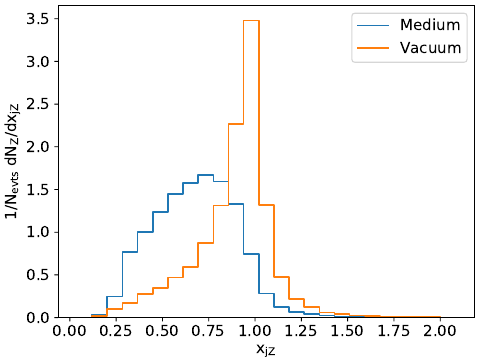
Figure 1 . Distribution of the transverse momentum ratio between the jet and Z -boson, x jZ , as provided by PYTHIA+JEWEL for Vacuum and Medium.